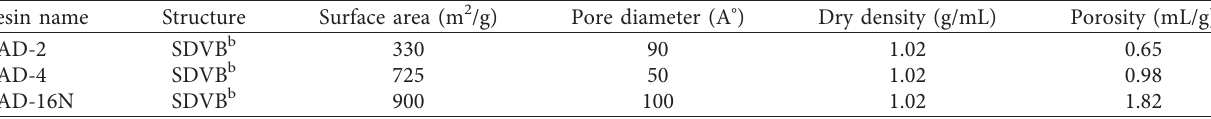
Table 1: Chemical and physical properties of the resins used a